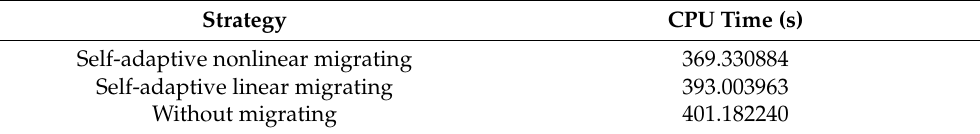
Table 5. CPU times of different migrating